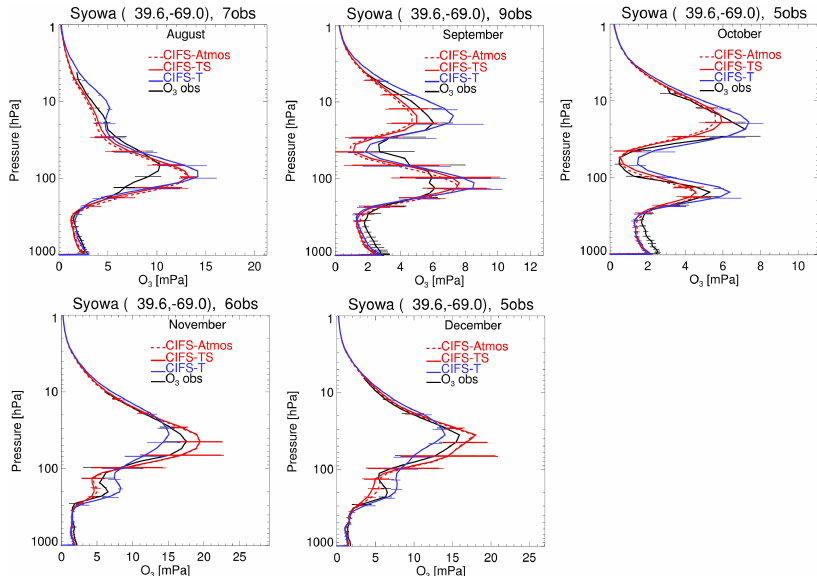
Figure 5. Evaluation of ozone in units mPa against WOUDC ozone sondes at Syowa station during August–December 2009. Black: ozone sonde; red dashed: C-IFS-Atmos; red solid: C-IFS-TS; blue: C-IFS-T. Error bars denote the 1 σ spread in the models and